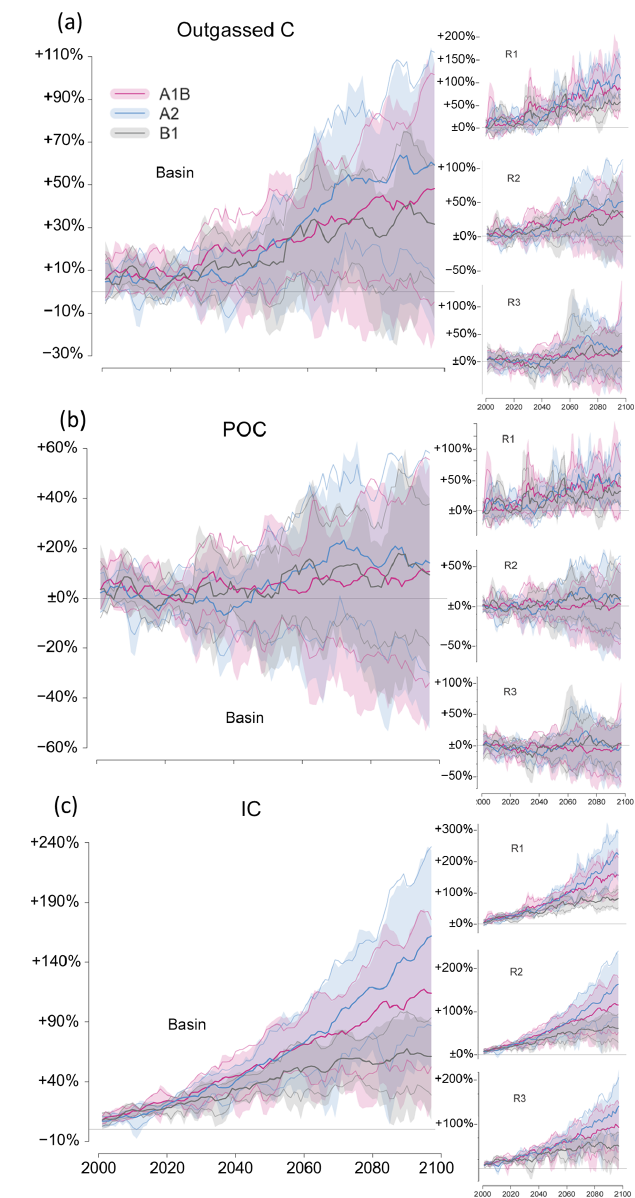
Figure 4. Temporal change in riverine carbon pools caused by cli- mate change. Panel (a) shows results for outgassed carbon, (b) for particulate organic carbon (POC) and (c) for inorganic carbon. Re- sults are shown as the quotient of annual carbon amount and mean annual carbon amount in reference period for the whole basin and the three subregions (R1–R3). Different colours represent differ- ent SRES emission scenarios. The shaded area for each scenario is spanned by the minimal and maximal values of all five climate models and scenarios. Bold lines represent the 5-year mean of the climate models and scenarios, and thin lines represent mean ± 1.0 standard deviation. Positive values indicate an increase in outgassed CO 2 in the future compared to reference period, and negative values indicate a decrease. The horizontal line at y = 1 indicates no change compared to the reference period